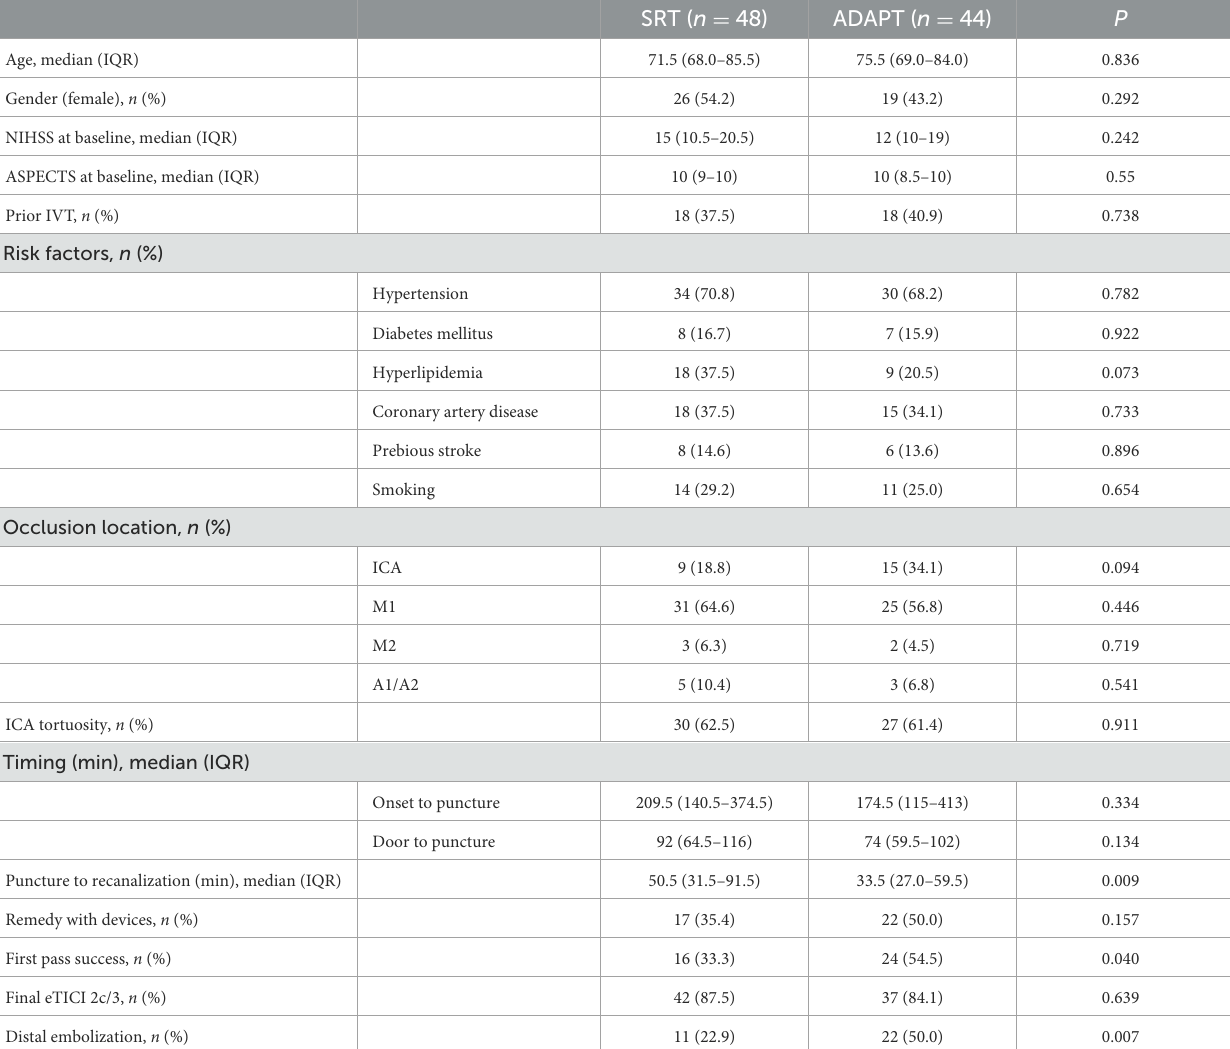
TABLE 1 Baseline characteristics of the stroke patients with AF treated by ADAPT or